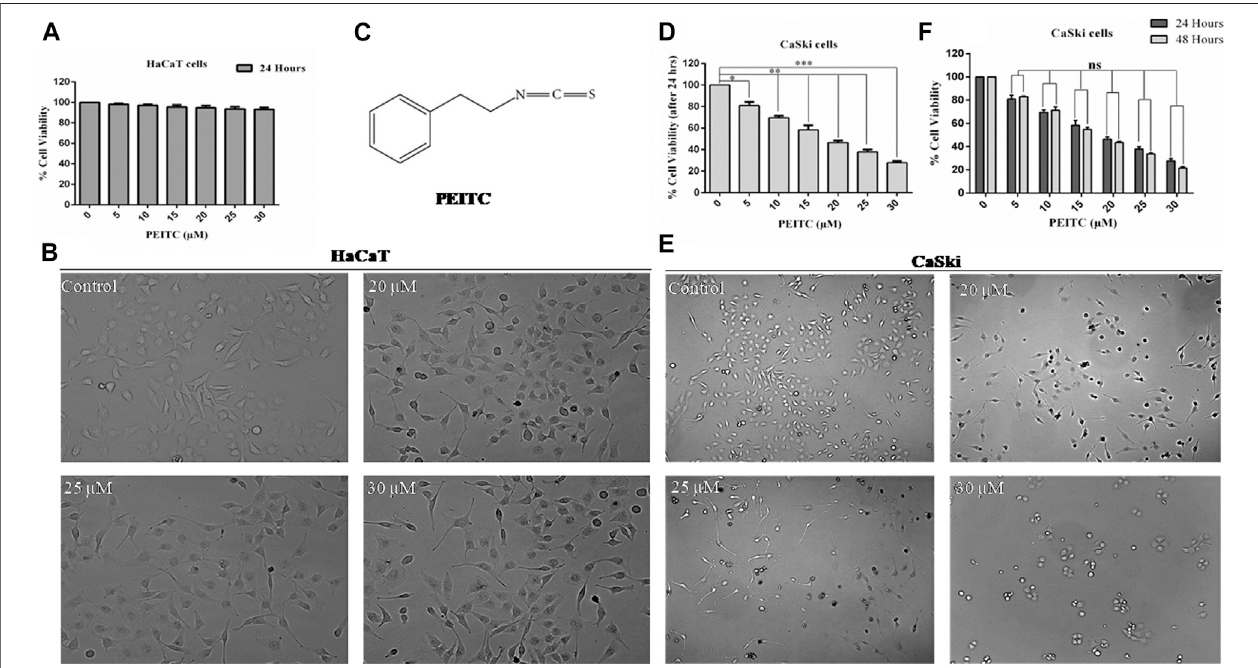
FIGURE 1 | Cell viability assay was performed to assess the effect of PEITC on HaCaT and CaSki cell lines. (A) PEITC exerted insigni fi cant cytotoxic effects on HaCaTcellsatvariousdoses. (B) Morphologicalanalysisshowedthatphenethylisothiocyanateatdosesof20,25,and30 μ Mdidnotsigni fi cantlyalterthemorphologyof HaCaT 24h after treatment. (C) Represents the structure ofphenethyl isothiocyanate. (D) Phenethyl isothiocyanate resulted in signi fi cantcytotoxic effects in CaSki cells after24hoftreatmentinadose-dependentmannerwhencomparedtotheuntreatedcontrol. (E) Cytotoxiceffectofphenethylisothiocyanateasanalyzedbyphase contrastmicroscopy.Similar tothecellviabilityresult, phenethyl isothiocyanate suf fi ciently inducedmorphologicalchangesin CaSkicellsat 20,25,and 30 μ Mafter 24h oftreatment. (F) Inhibition ofcell survivalafter 48h oftreatment with phenethyl isothiocyanate further increased ascompared tothatafter 24 hinCaSki cells.The graphs represent ± SD of three independent experiments. The image is the representation of three independent experiments. * p value < 0.05 compared with the untreated control was considered statistically signi fi